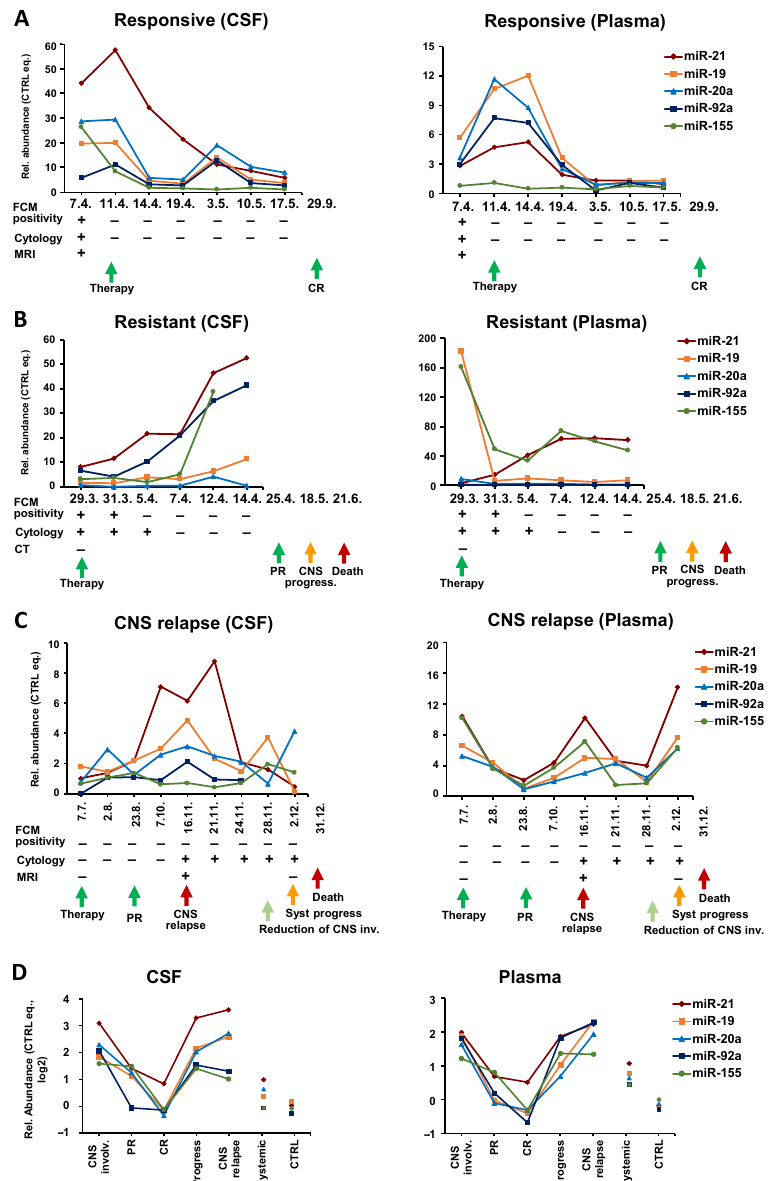
Figure 4. Dynamics of oncomiRs during therapy of CNS lymphoma patients. Levels of indicated oncomiRs in cerebrospinal fluid (CSF, left panel) and plasma ( right panel) of patients during treat- ment. ( A ) B-NHL-NOS patient with secondary CNS involvement responding to therapy; ( B ) BL patient with secondary CNS involvement resistant to therapy; ( C ) DLBCL systemic patient who relapsed/progressed to CNS. Below the x-axes the following are indicated: date of sampling and positivity/negativity of findings of flow cytometry/cytology of CSF, magnetic resonance imaging (MRI), and computed tomography (CT). ( D ) Median values of oncomiR levels of patients during the course of the disease of CNS-involving lymphomas, compared to systemic lymphomas and non-lymphoma controls. Abbreviations: CNS inv. = CNS involvement at the time of diagnosis; PR = partial remission; CR = complete